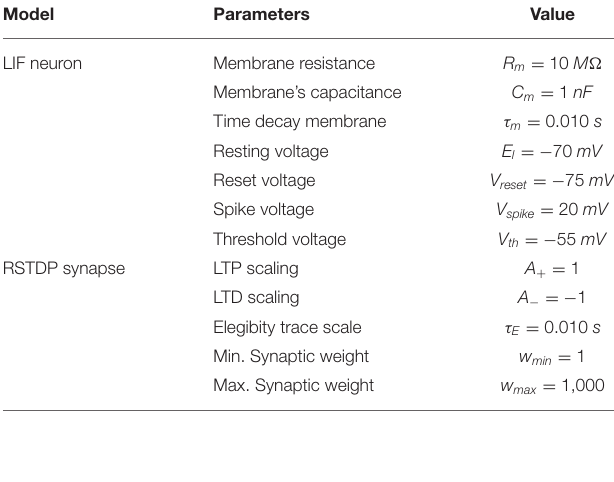
TABLE 1 | Neuron and synapse modeling